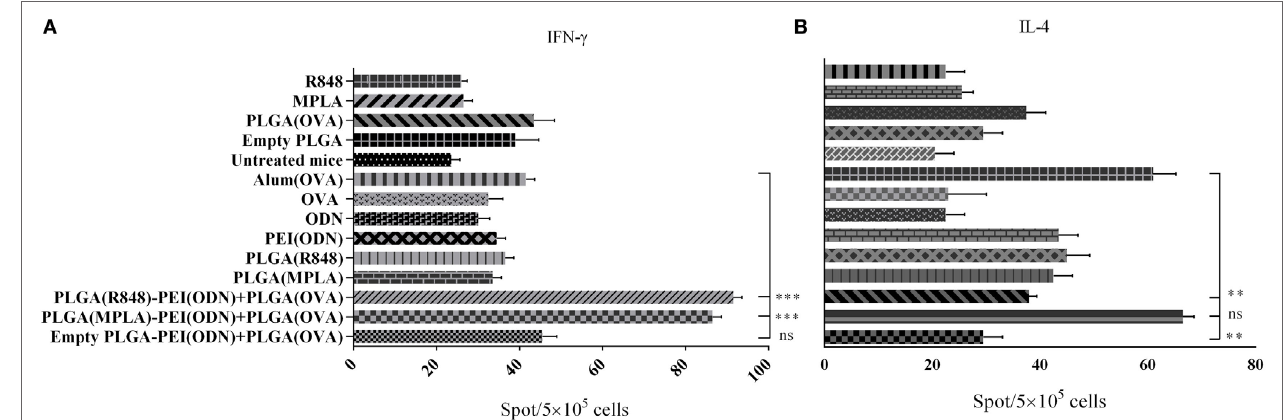
FigUre 8 | The effect of different poly(lactic-co-glycolic) acid (PLGA)/polyethylenimine (PEI) formulations harboring dual toll-like receptor (TLR) agonists as adjuvant in inducing cellular immune responses evaluated by measuring the number of IFN- γ and IL-4 producing splenocytes using ELISpot assay. BALB/c mice (three mice per group) were immunized twice (at days 0 and 21) with different dual core–shell adjuvant and PLGA [ovalbumin (OVA)] NP formulations. On day 7 post booster, mice from each group were sacrificed, and their splenocytes were stimulated with OVA protein for 24 h. IFN- γ and IL-4 release from splenocytes induced by different PLGA/PEI adjuvant formulations were determined using ELISpot assay. The data indicate the mean ± SEM ( n = 3) ** P ≤ 0.01, *** P ≤ 0.001 (one-way analysis of variance). The asterisks located on top of the lines showed comparison of significance between the main (dual TLRs agonist) and control (OVA + aluminum hydroxide)